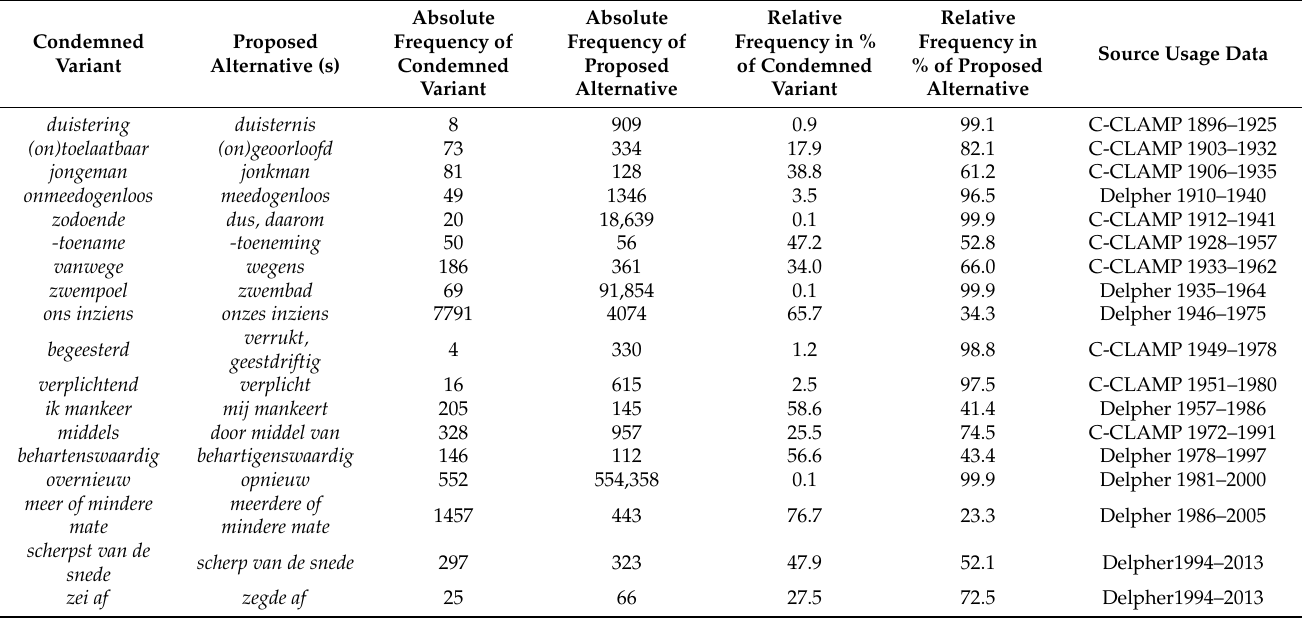
Table A3. Lexical usage items with year(s) of prescriptive utterance, absolute and relative frequency counts of condemned and approved variants in usage, and source of the usage data.